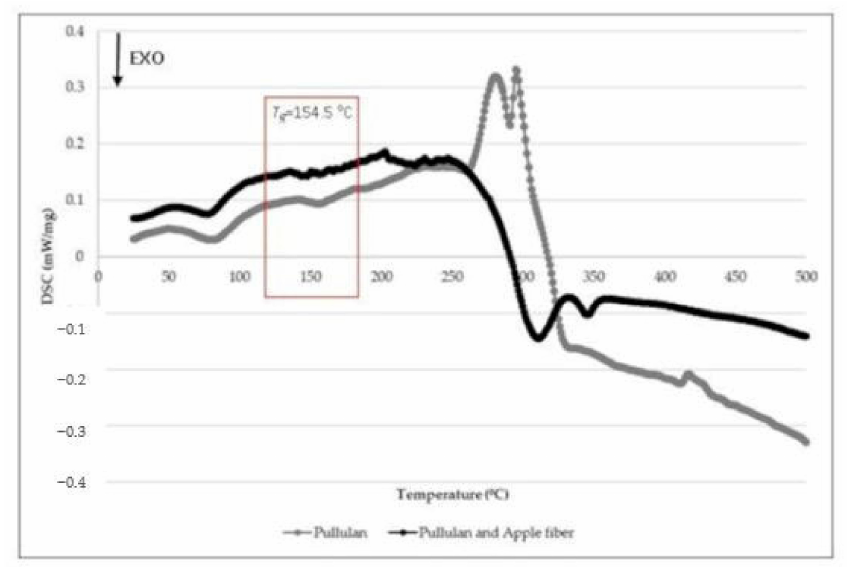
Figure 3. Differential Scanning Calorimetry (DSC) results of the biocomposite